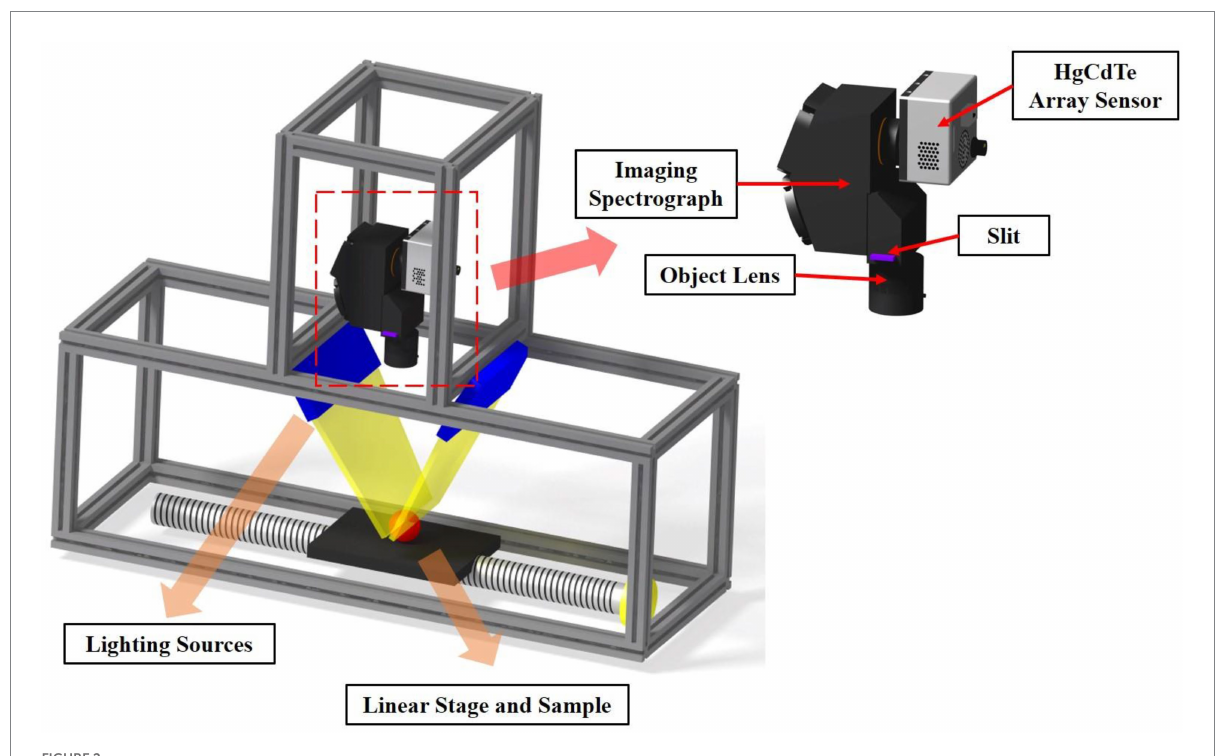
FIGURE 2 Schematic of hyperspectral imaging system and the hyperspectral